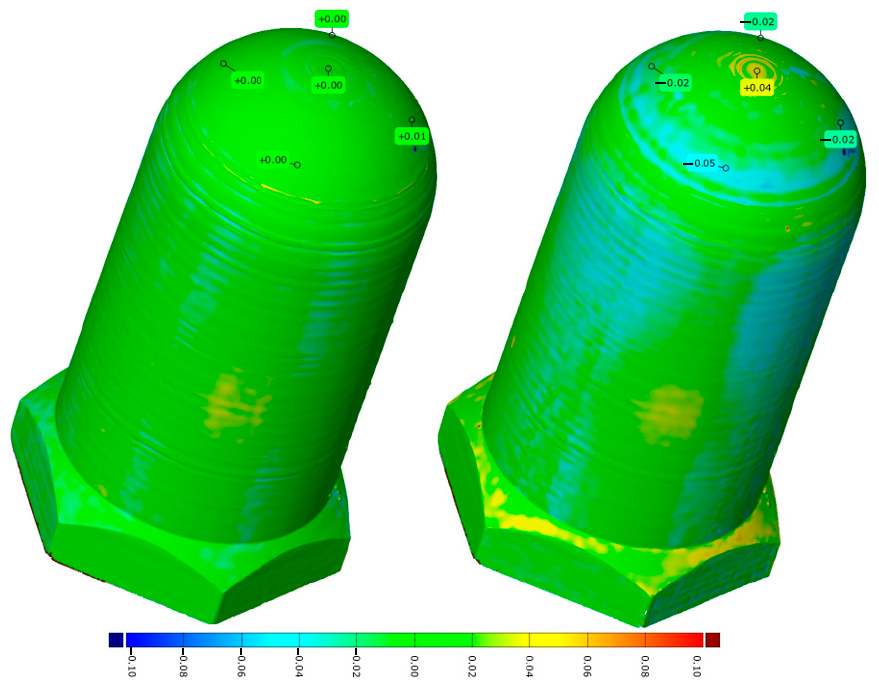
Figure 13. Wear of punch in Test 4_FE_1 between 5 ( left ) and 100 pieces ( right ). All values are in mm unit. Table 17. Wear of punch in Test 4_FE_1 between 5 and 100 pieces, measured values at given points. Test 4_FE_1 Wear Measurement